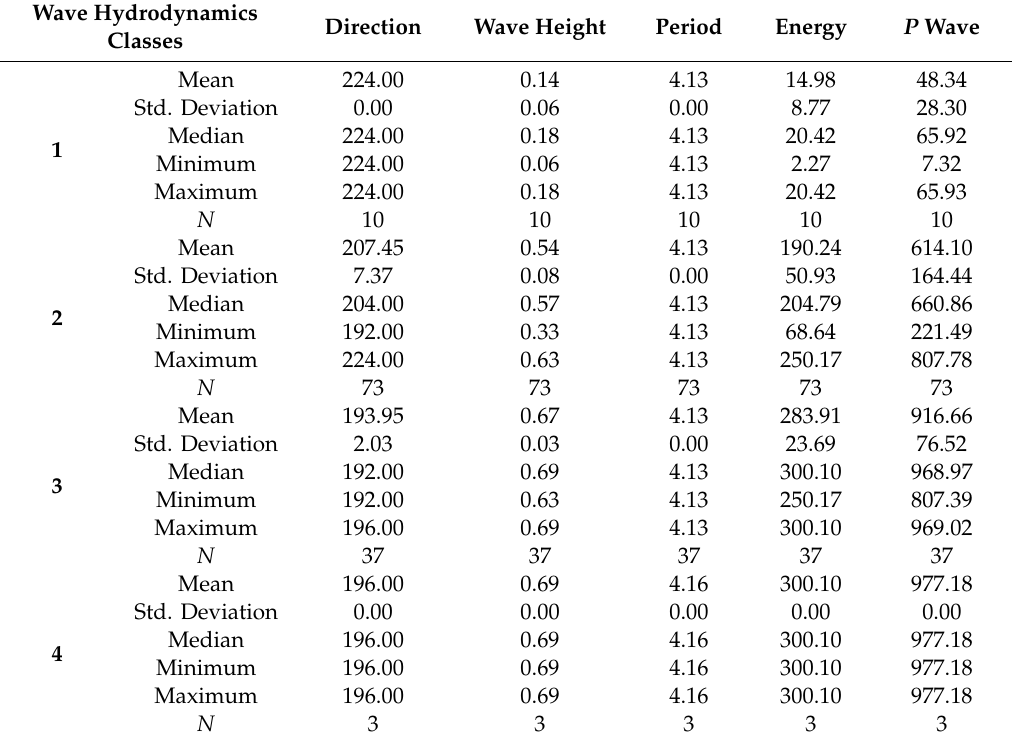
Figure 6. Distribution of the waves’ energy ( a ) and the waves’ power ( b ) at each sampling point. HCA results suggested to subdivide the wave hydrodynamics profiles of the Gulf into four classes of increasing hydrodynamics / energy (see Table 5). These classes have been tested as fixed factors in the Kruskal Wallis test design. Table 5. Characteristics of the four wave hydrodynamics classes.